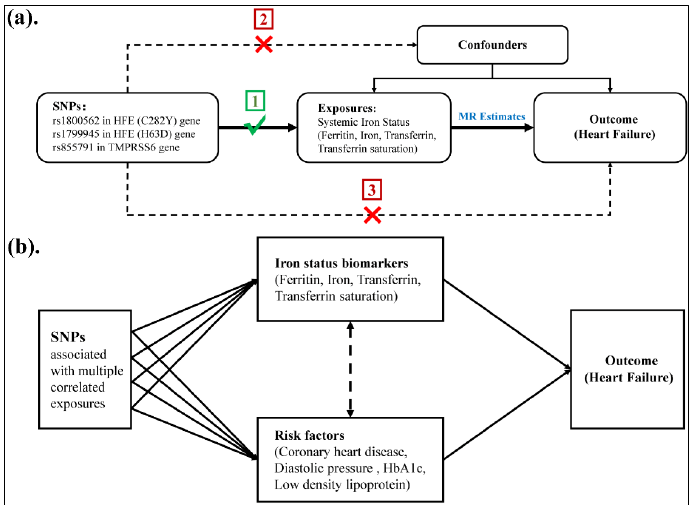
Figure 1. Schematic diagram of the Mendelian randomisation study design. ( a ) Two-sample Mendelian randomisation (TSMR). ( b ) Multivariate Mendelian randomisation (MVMR).